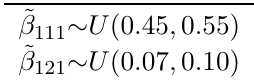
Table 2: Uniform distributions for the time-based